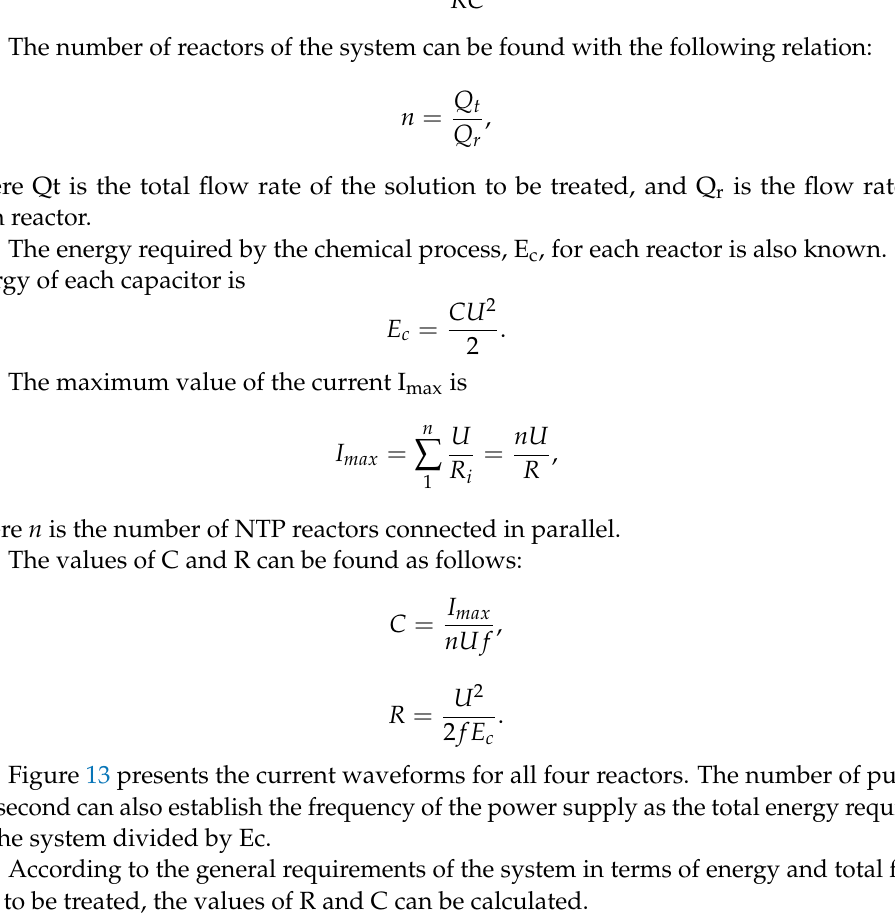
Figure 12. The current waveforms for each reactor were